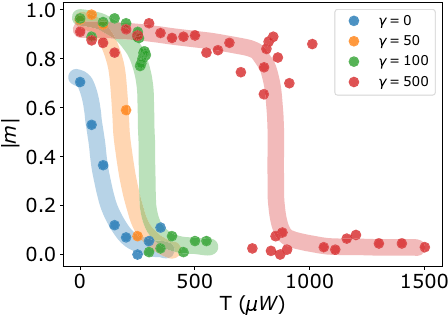
Fig. 3 Ground state magnetization of the nonlinear optical Ising machine. Here, the experimental parameters are slightly off compared to the results shown in Fig. 2c. The magnetization drops to zero continuously at γ = 0 (blue), 50 (orange) and abruptly at γ = 100 (green), 500 (red) with the thick lines the guides to the eyes. Error bars are similar to Fig.